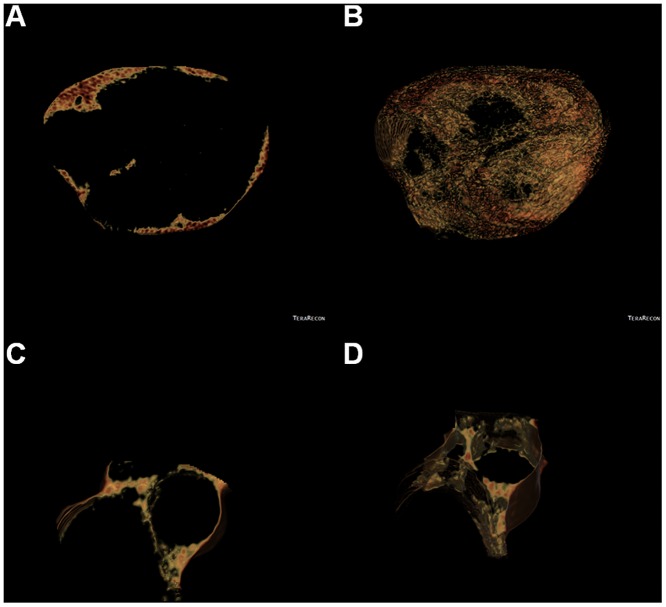
The illustration of single PCF (A) or TAT (C) slice re-construction by using dedicated CT software (Aquarius 3D Workstation, TeraRecon, San Mateo, CA, USA) and subsequent semi-automatic 3D volumes (B: PCF, D: TAT) using CT dataset by summation methods in our current study.